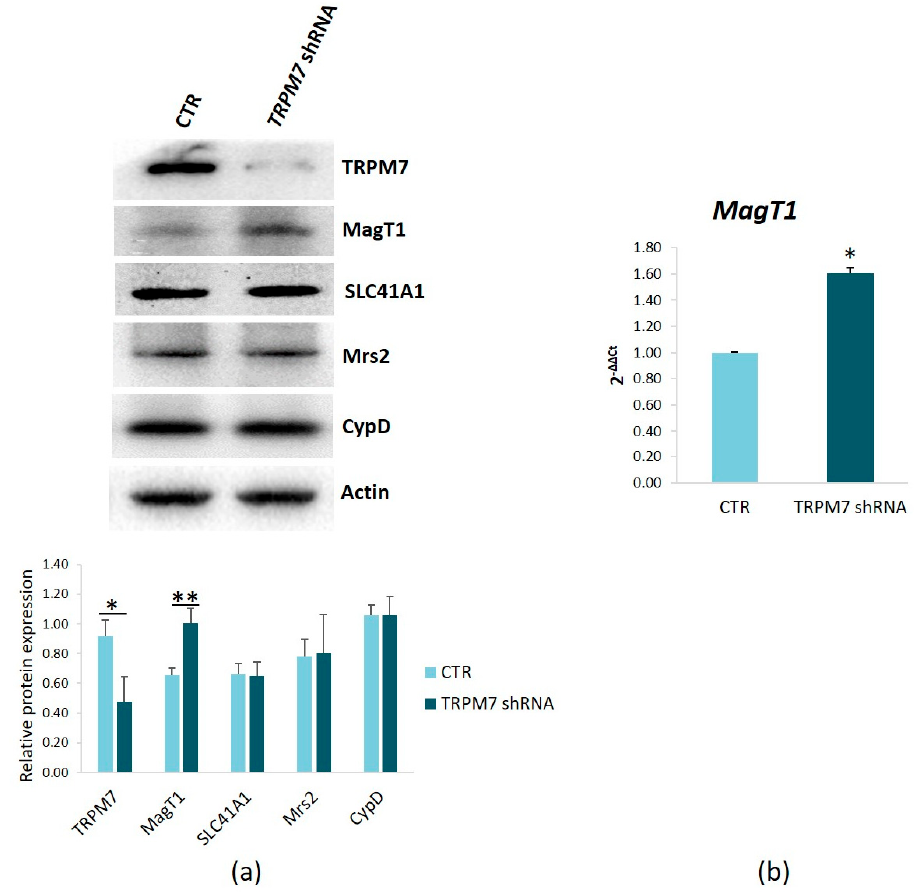
Figure 7. Expression of Mg transporters/channels in TRPM7-silencing HUVEC. ( a ) Protein lysates from TRPM7-silencing/-expressing HUVEC (TRPM7 shRNA and CTR, respectively) were analyzed by Western blots using antibodies against TRPM7, MagT1, SLC41A1 and Mrs2. Anti-actin antibodies were used as controls of equal loading for TRPM7, MagT1 and SLC41A1, while Mrs2 was normalized on CypD. A representative blot of three independent experiments is shown (upper panel). Densitometry of the bands on three different blots was performed with the software ImageLab (lower panel). ( b ) Real-Time PCR was performed on RNA extracted from TRPM7-silencing/-expressing HUVEC. Primers designed on MagT1 sequence were used. Data are expressed as the mean ± SD. * p ≤ 0.05, ** p ≤ 0.01.